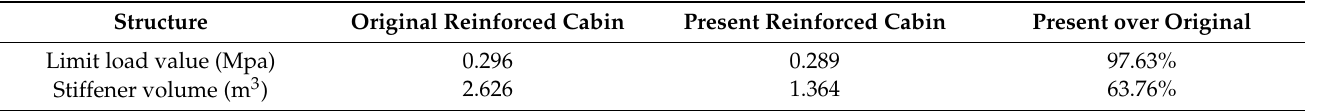
Figure 12. T ‐ ribs and reinforcement: ( a ) T ‐ ribs; ( b ) T ‐ rib reinforcement. Table 4. Comparison of the reinforcement effects with different reinforcing